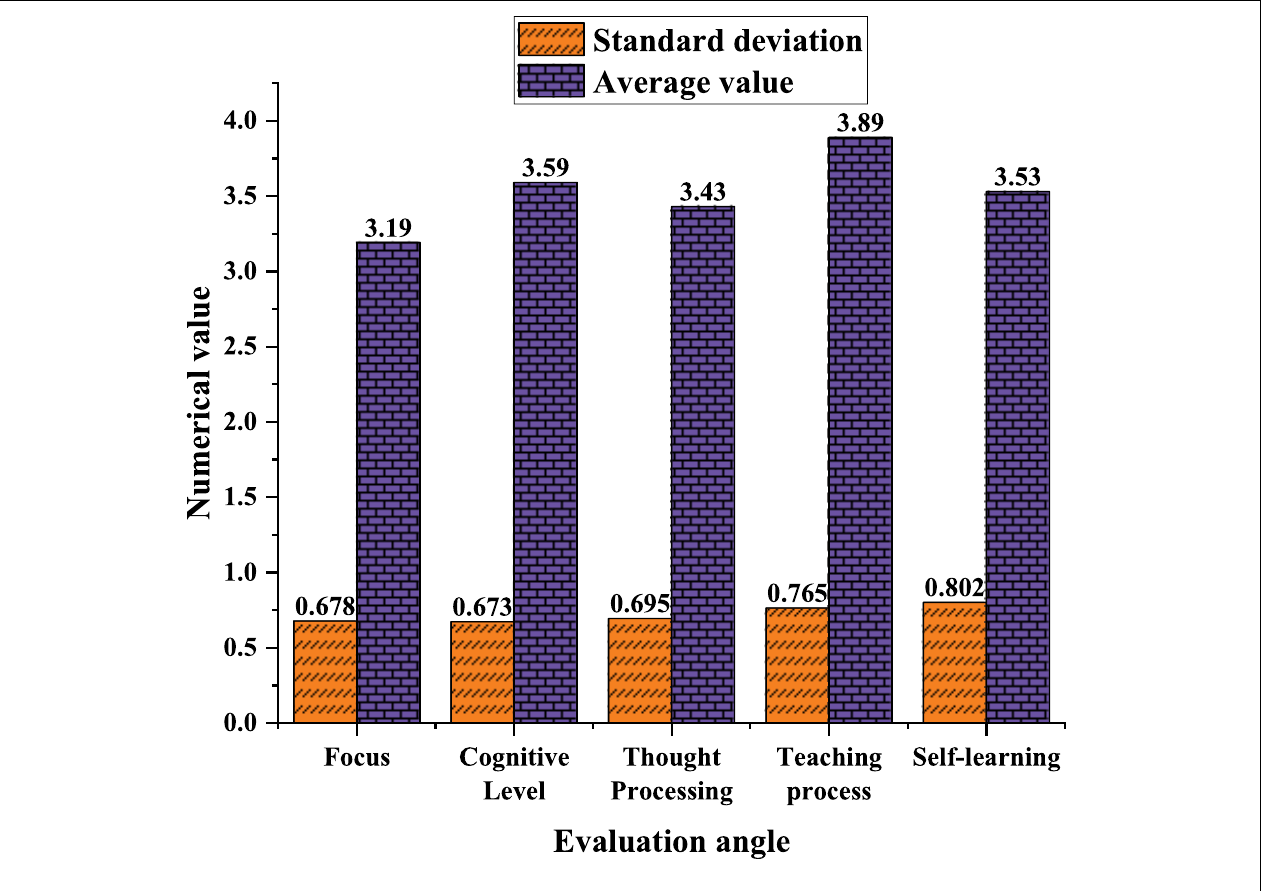
FIGURE 6 | The standard deviation of data